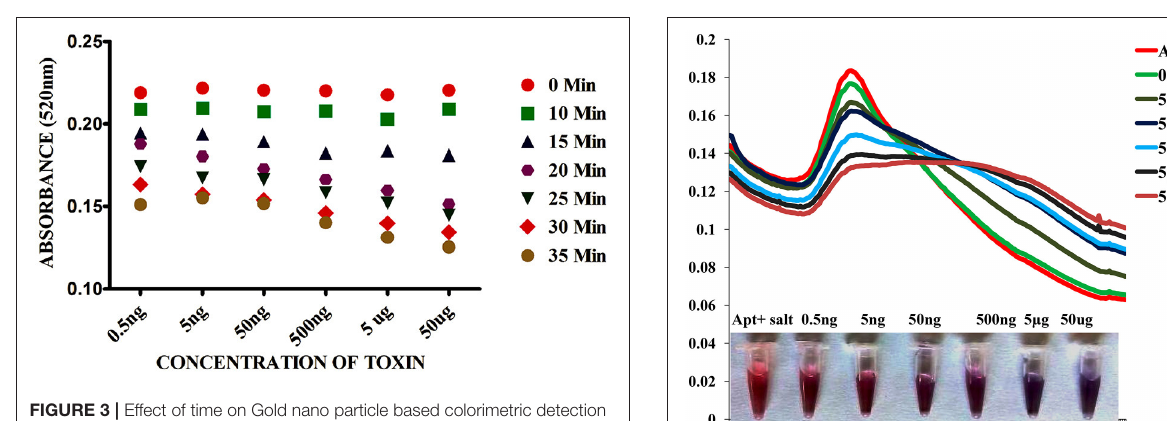
FIGURE 3 | Effect of time on Gold nano particle based colorimetric detection assay. The absorption value profiles at 520nm of the sensor for different concentrations of SEB.